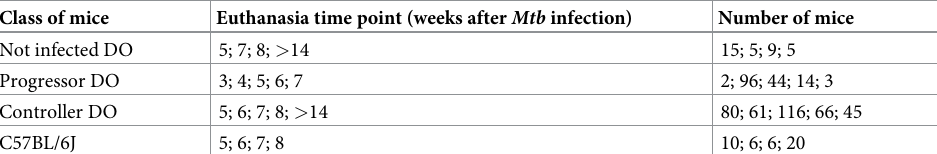
Table 1. Mouse class, euthanasia time points (weeks after Mtb infection), and numbers of mice used to quantify proteins in lungs. The first column denotes the class of mice; the second column denotes the euthanasia time point (weeks after Mtb infection); and the third column denotes the number of mice euthanized in each week separated by semi columns. There was substantial overlap in euthanasia weeks for the 4 classes. No progressor DO mice survived longer than 8 weeks, so none could be included in the > 14-week timepoint. The table contains information from the same 5 independent experimental infections shown below in Fig 3, panels A-K; and Fig